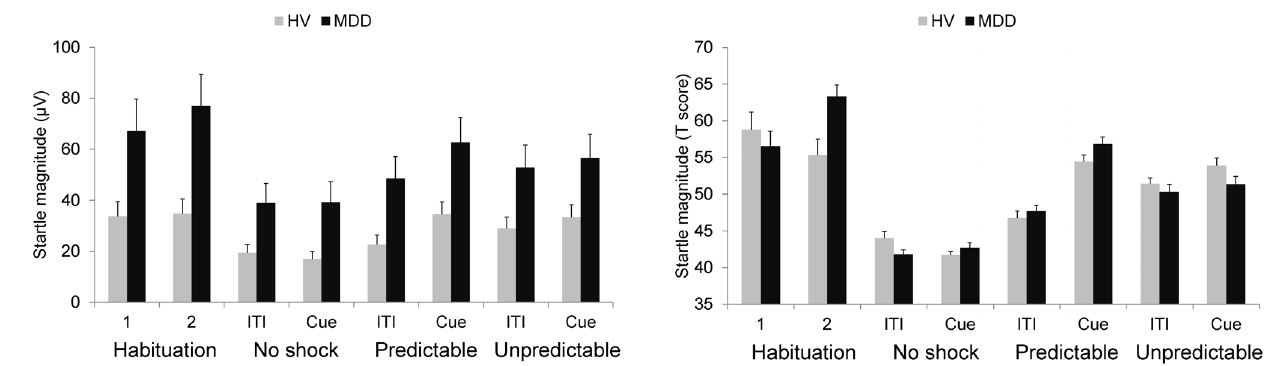
Figure 3. Startle response during NPU (T scores). Startle magnitudes (T scores) in the controls and patients with major depressive disorder (MDD) during the habituation and threat proce- dures . Error bars are SEM.